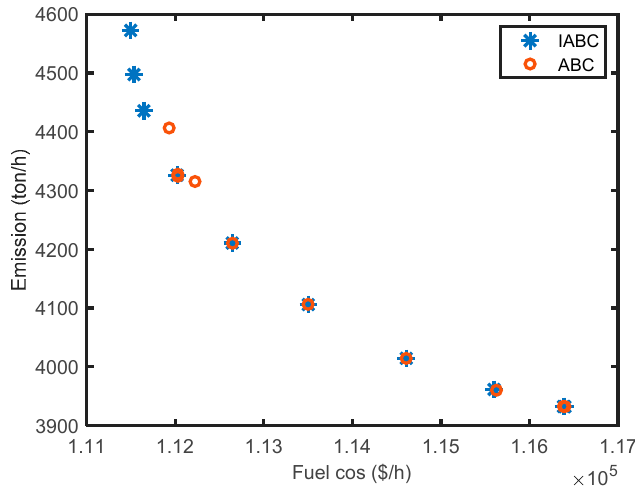
Figure 5. Pareto solutions for case 1.